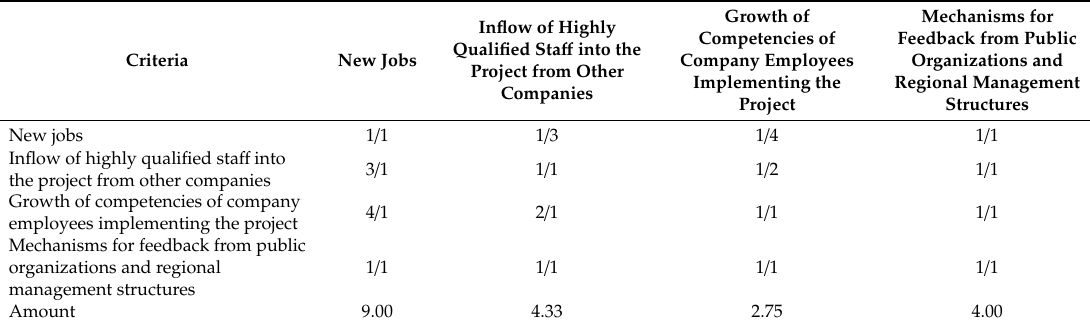
Table A5. Results of assessment of relative importance of social sustainability criteria.